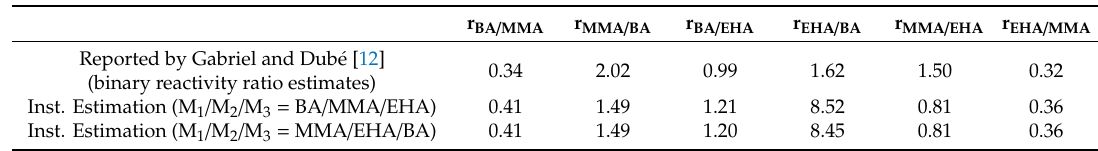
Table 4. Reactivity ratio estimates for terpolymerization of BA / MMA / 2-ethylhexyl acrylate (EHA) from low conversion data (experimental data from